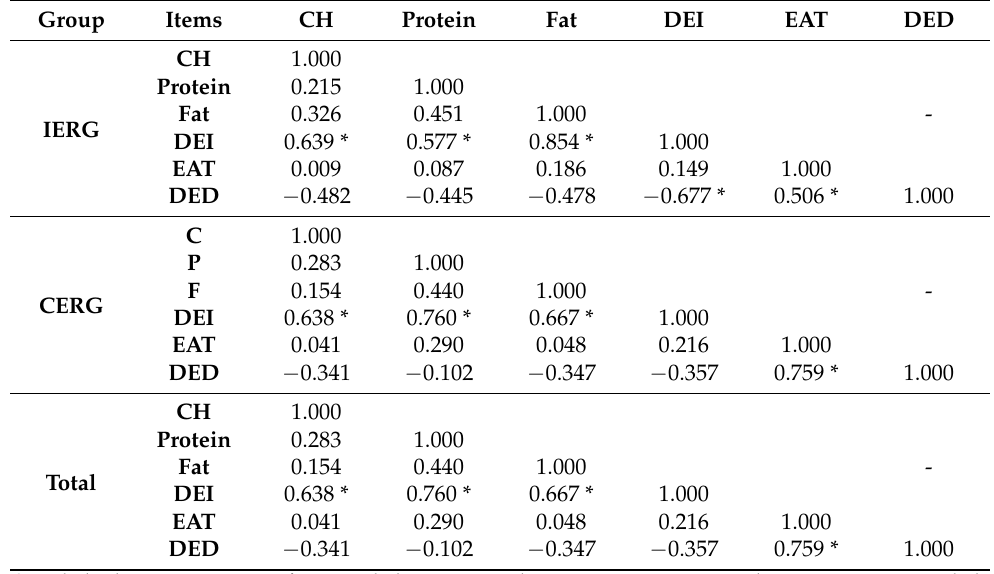
Table 7. Correlation analysis between the effect of the plan and the variables in the daily report.